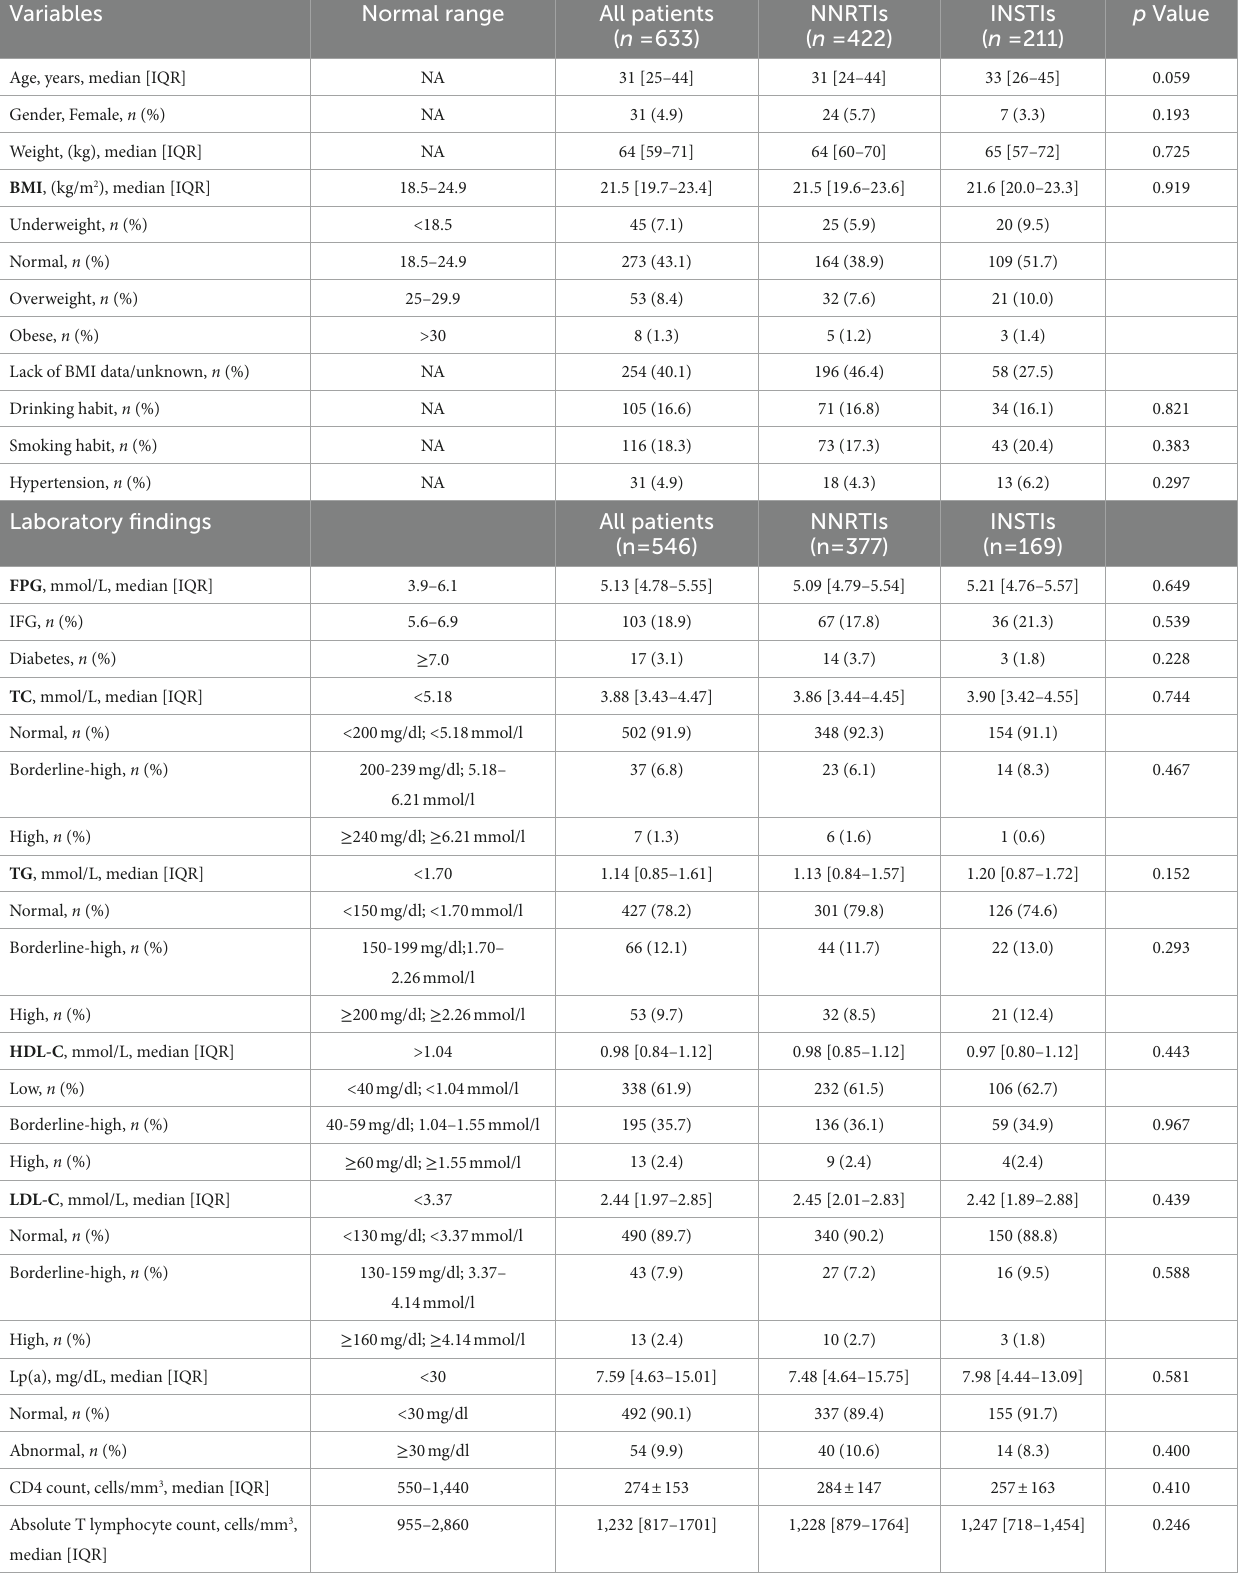
TABLE 1 Baseline characteristics of HIV patients before receiving ART by types of ART regimen.